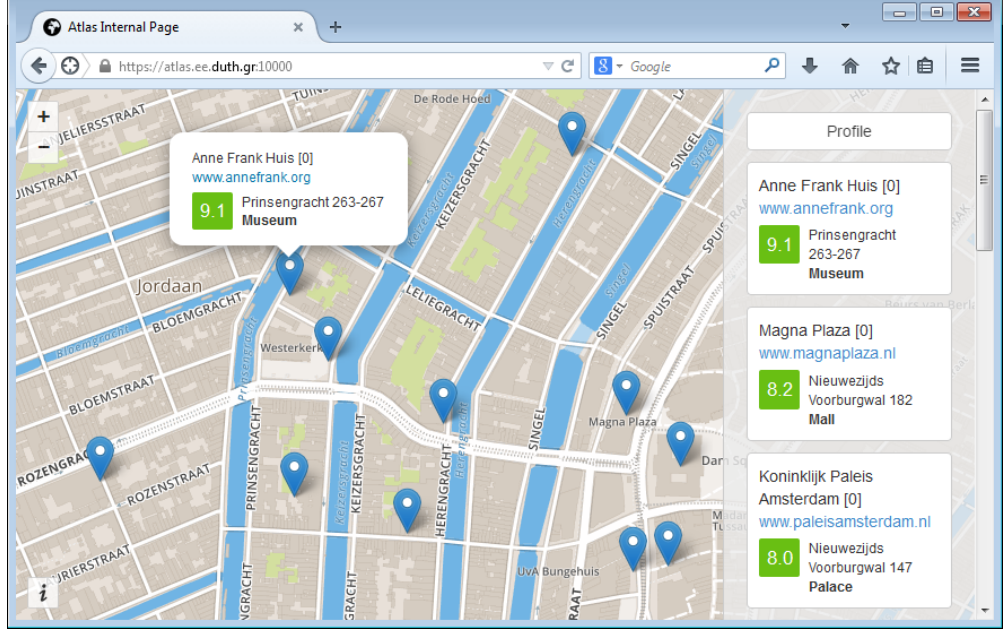
Figure 7. Contextual suggestion web